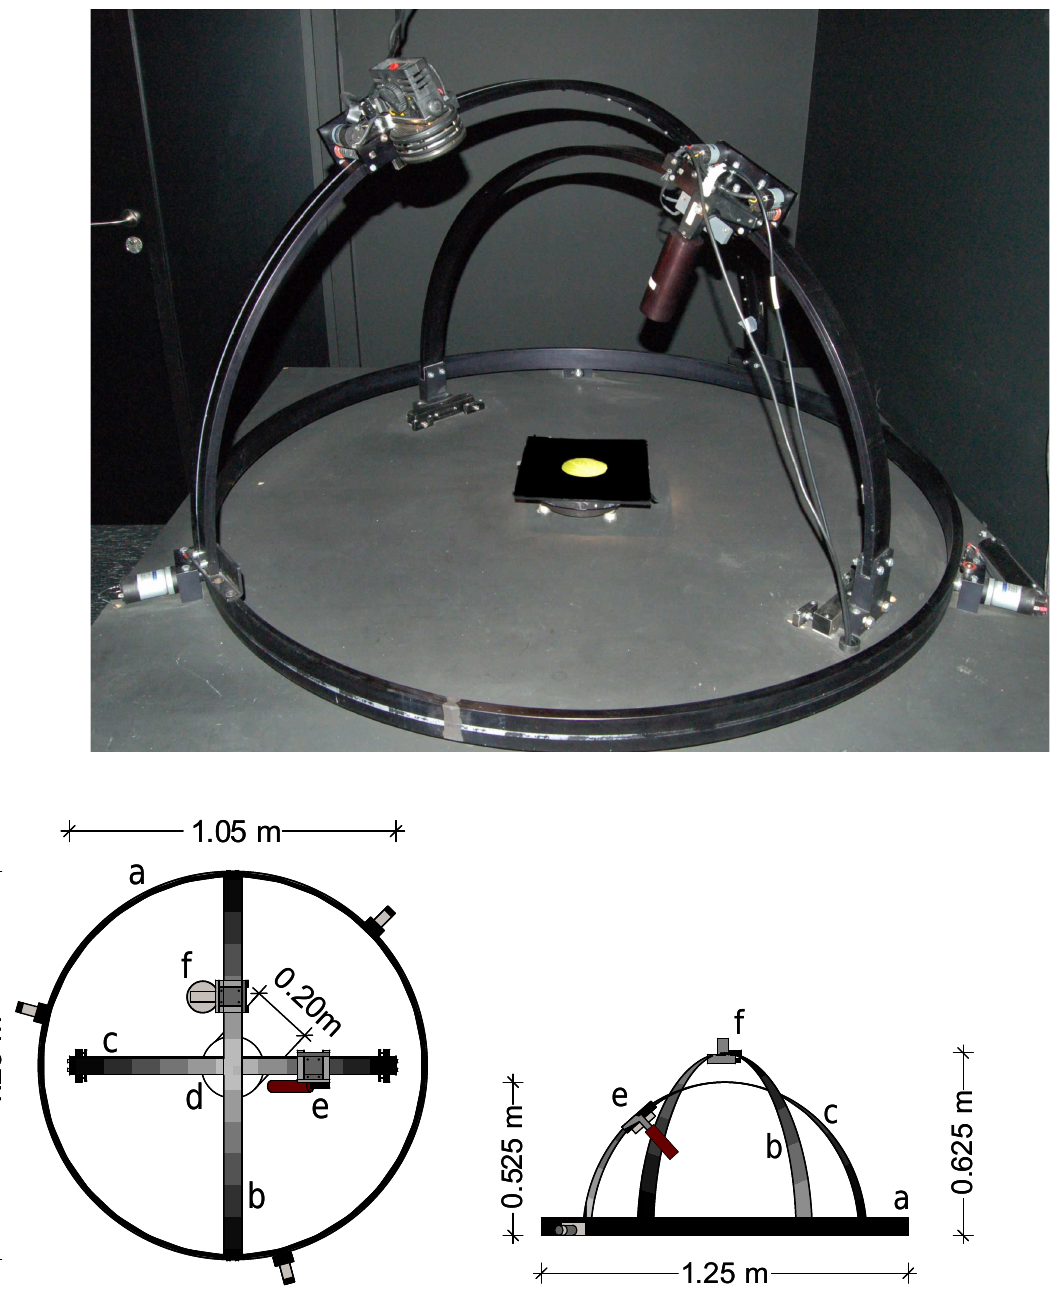
Figure 1. Picture and mechanical system setup of the Compact Laboratory Spectro- Goniometer (CLabSpeG). In the horizontal plane an aluminum rail (a) supports the light source arm (b) and rotates anti-clock wise with a resolution of 30°. A stationary arm (c) supports the hyperspectral sensor. Light source (f) and spectroradiometer (e) have an operational resolution of 15°. In the centre there is the sample holder including a leaf (d), rotating clock-wise with a resolution of